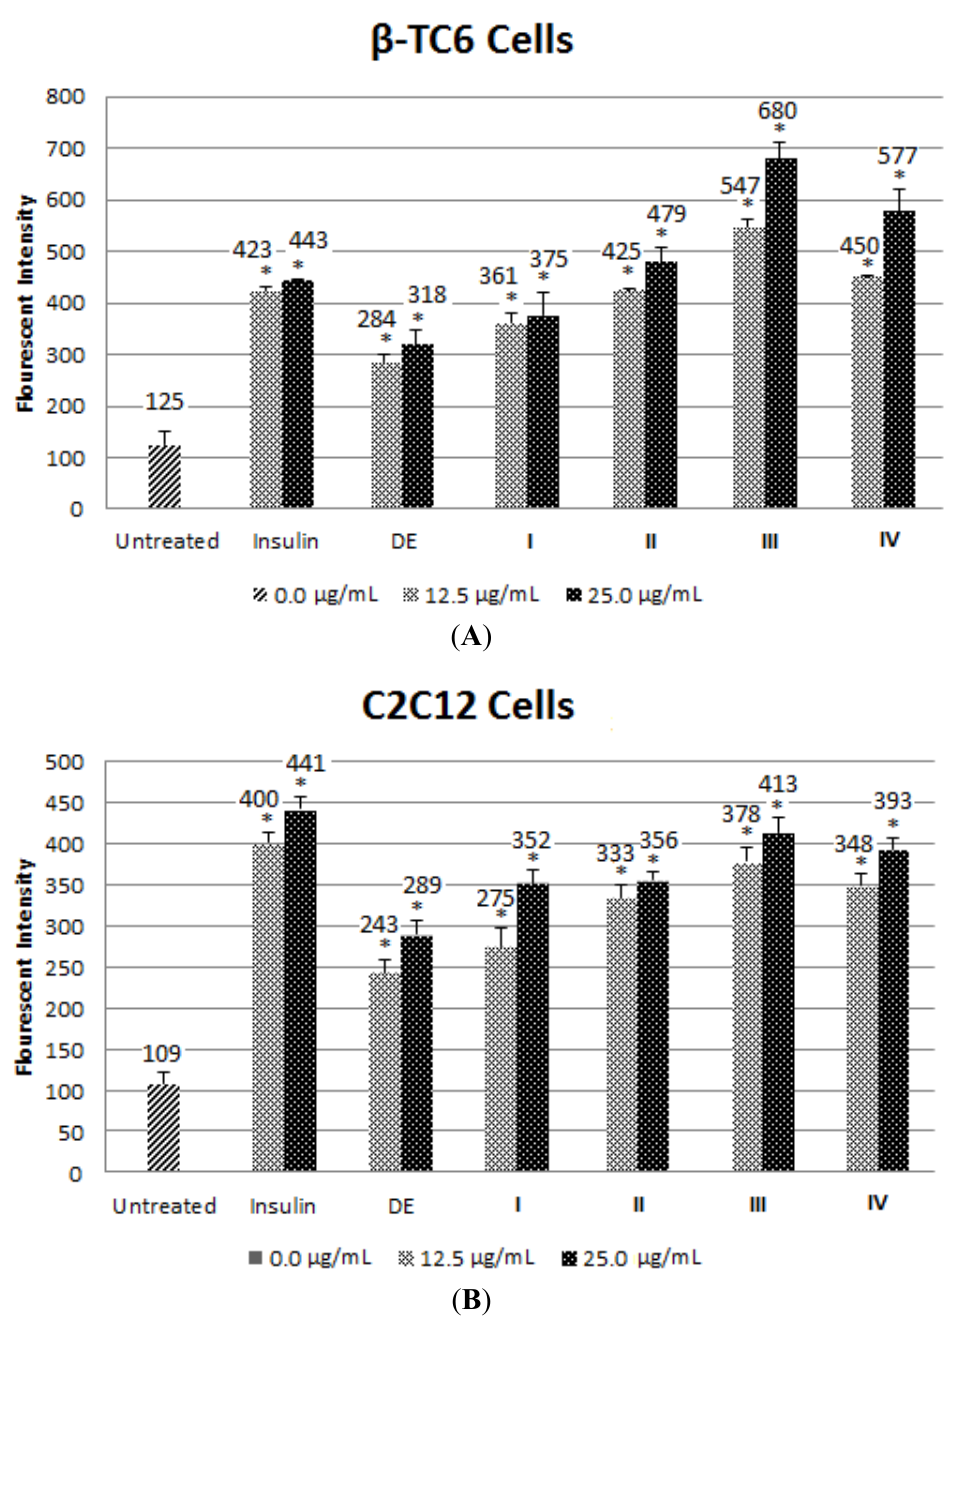
Figure 5. ( A , B ) Bar chart showing fluorescent intensity of 2-NBDG taken up by β -TC6 and C2C12 myoblast cells. Insulin was included as positive controls. (* p < 0.05) ( C , D ) Representative photos showing enhanced glucose uptake by β -TC6 and C2C12 after treated with 25 µg/mL of alkaloids I – IV . Blue:Hoechst, Green: